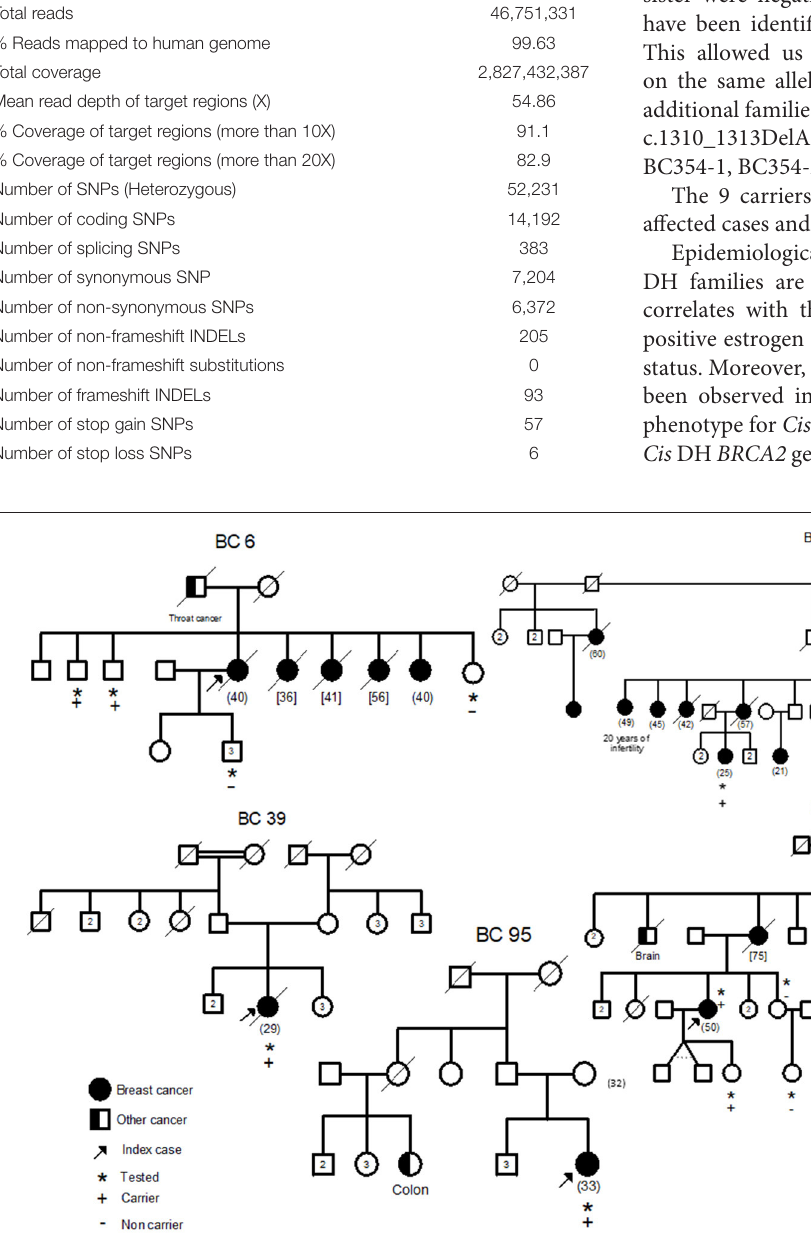
FIGURE 2 | Familial pedigrees of the 5 Cis double heterozygous families. Available age at diagnosis of breast cancer cases is indicated between brackets. For some cases, only age at death was available and is indicated in square brackets. BBC, Bilateral Breast Cancer.